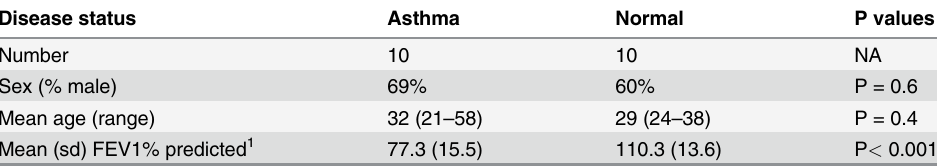
Table 1. Characteristics of all subjects used in the study.